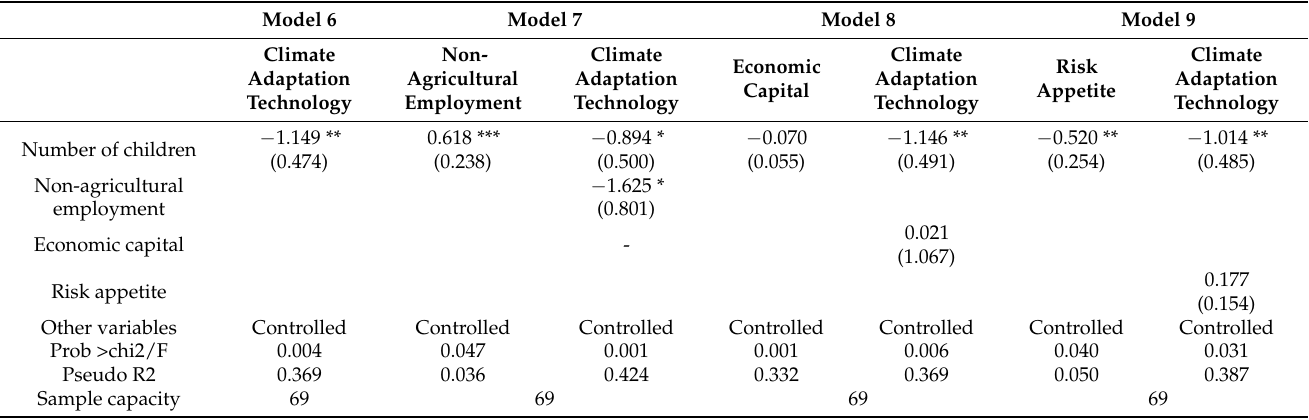
Table 6. Test of influencing factors and action mechanism of farmers’ climate adaptive technology in upbringing